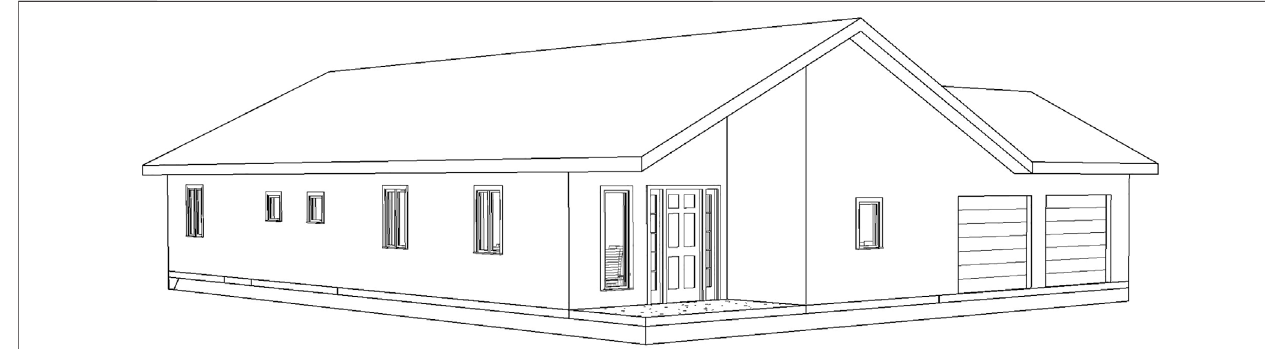
FIGURE 3 | 3D Schematic of the case study